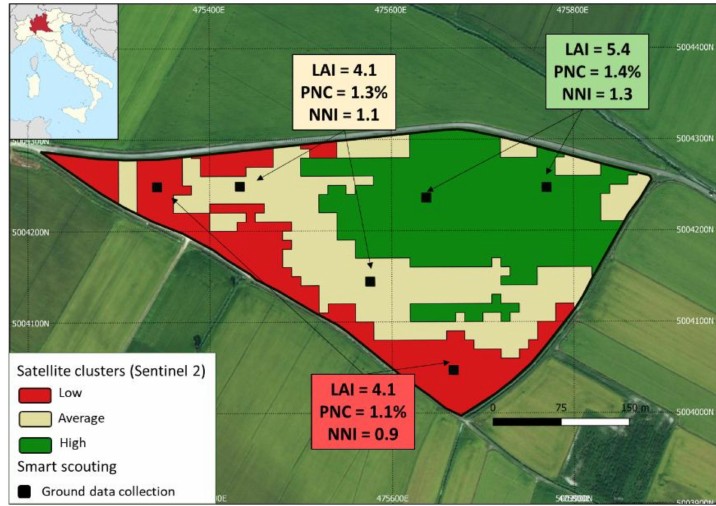
Figure 4. Example (for northern Italy) of the integration between satellite data and geo-located smart app-based N nutritional index (NNI) estimates. A cluster map from the 6 July 2018 NDRE (Normalized Difference Red-Edge) Sentinel 2 image was used to identify points where NNI was determined on 11 July (black